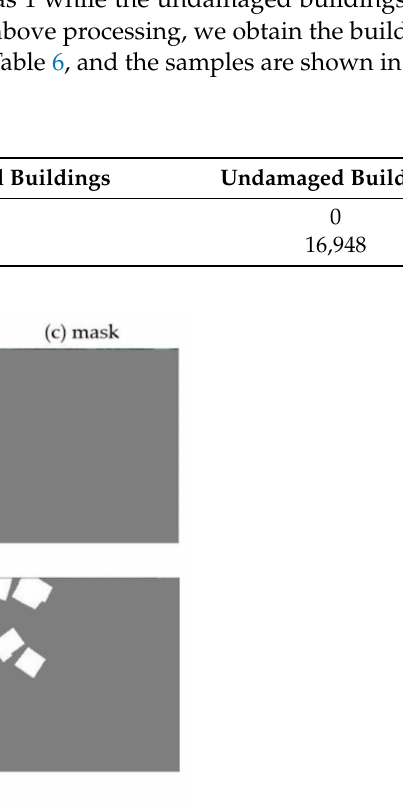
Figure 4. The samples of building data set. ( a – c ) represent the pre-disaster, post-disaster images, and mask, respectively, each row is a pair of images, while two rows in the figure represent two different